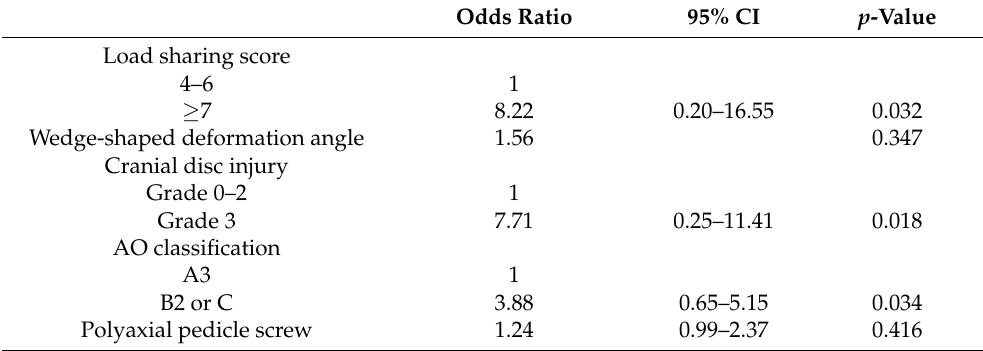
Table 5. Multivariate